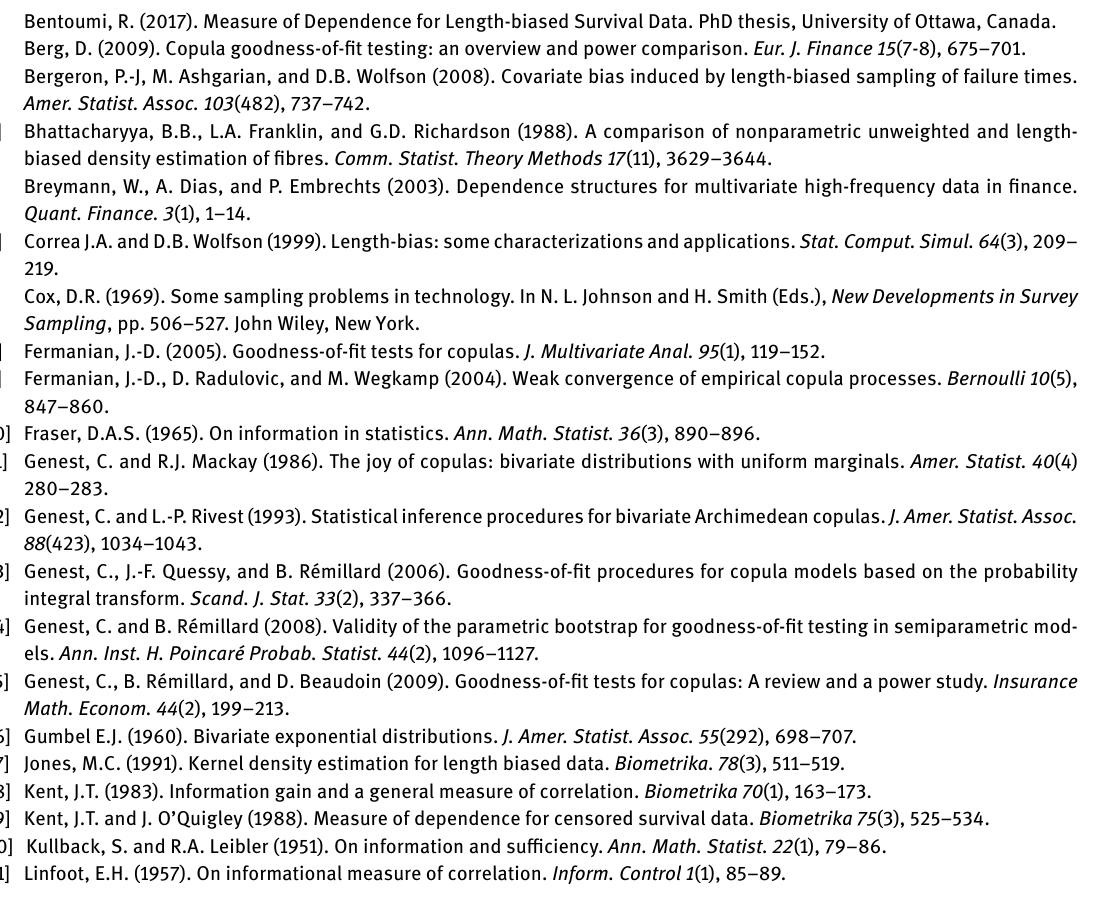
Table 5 indicates that, the new value of the shape r = 0.6 influences considerably ˆ Γ from Table 6, the difference between estimated conditional and joint dependence measure is very significant andhencewecanconcludethatgivenlength-biaseddatawecannotignorethepotentialeffectofthecovariate on the survival